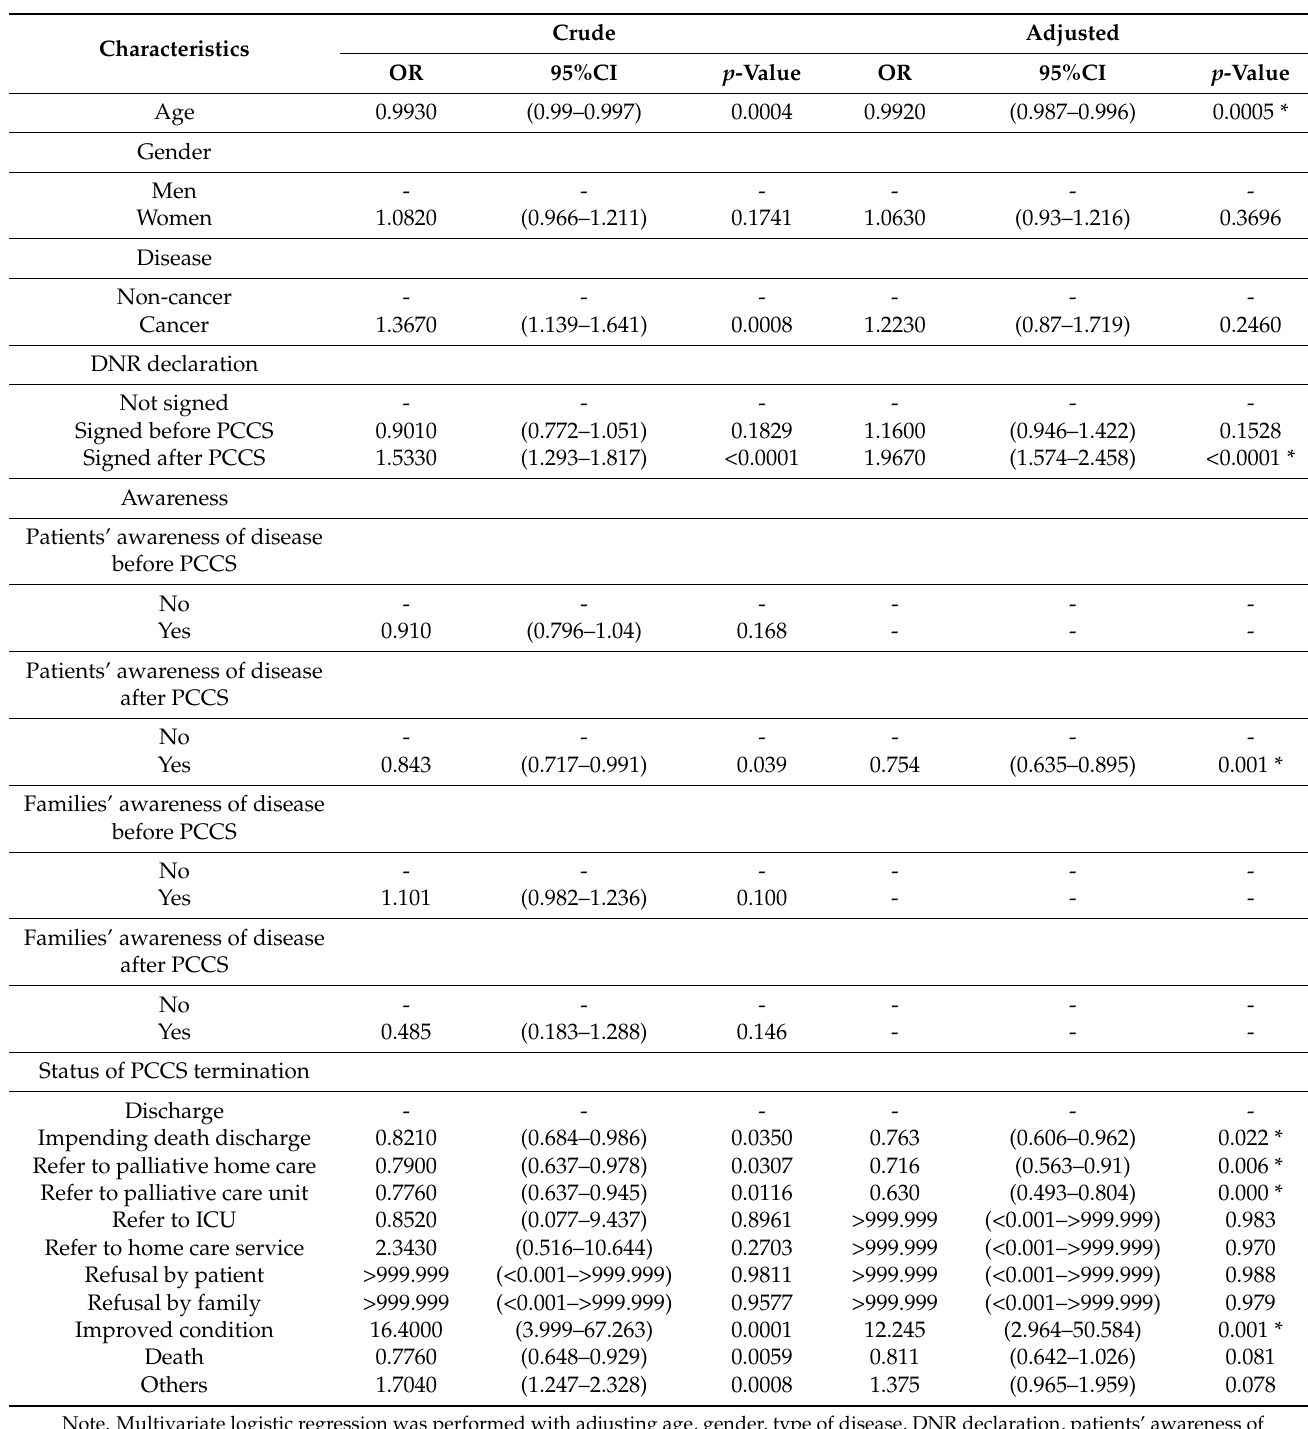
Table 3. Determinants of late referral to PCCS analyzed by logistic